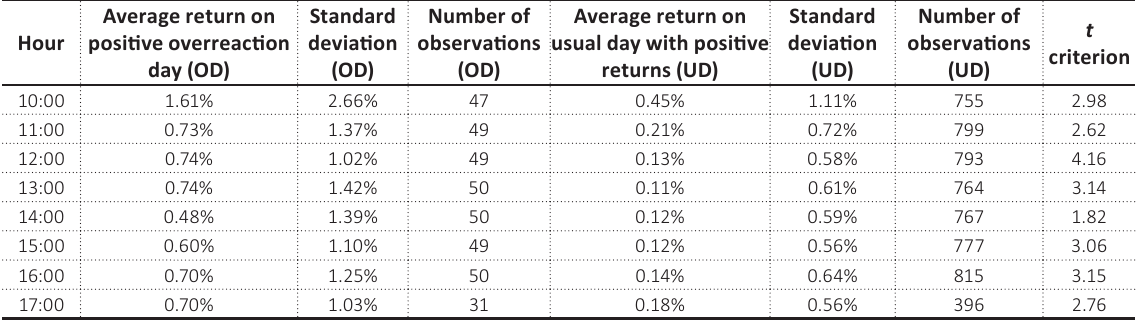
Table 1. T -test of hourly returns on overreaction and normal days: the case of positive overreactions, UX-C